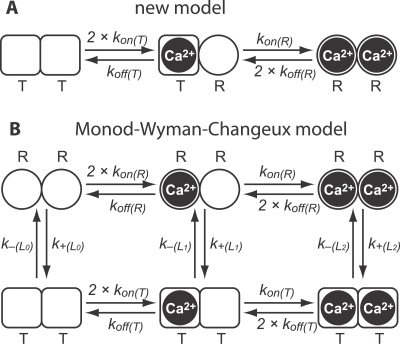
Models Used to Simulate CooperativityBoth models used to simulate cooperativity are based on the ability of the binding sites to occur in two states, one with a low affinity for Ca2+ (T) and one with a high affinity (R). In the new model (A), a binding site is in the T state when the other binding site has no Ca2+ bound, and it is in the R state when the other site has Ca2+ bound. In this model, the transitions from T to R and vice versa are considered to occur instantaneously. In the MWC model, the cooperative pair of binding sites are either both in the T state or both in the R state. The transitions between R and T occur according to the transition constants k
+ and k
−. For each occupation level, there is a separate equilibrium (L
0, L
1, and L
2) for which it can be shown that under specific conditions, the equilibrium shifts from mainly the T state in the unoccupied cooperative sets to mainly the R state in fully occupied states (see also Equations 8, 9, and 10).